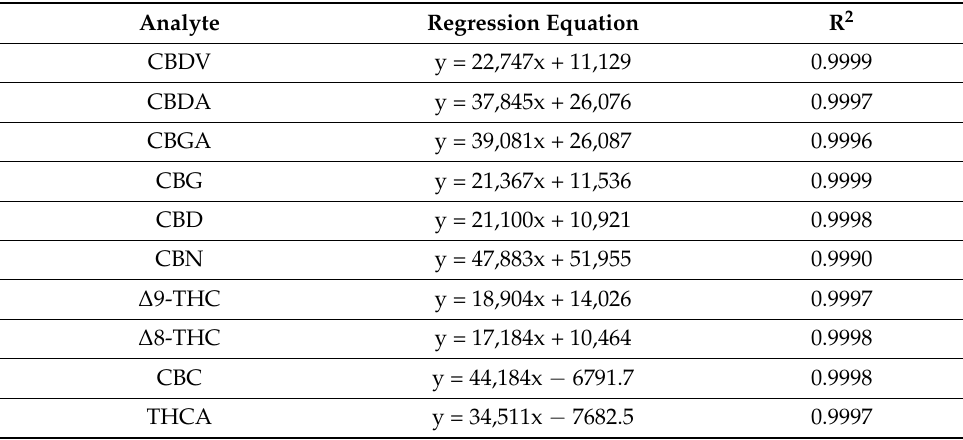
Table 4. Results for linearity, regression equation, and R 2 for each analyte.